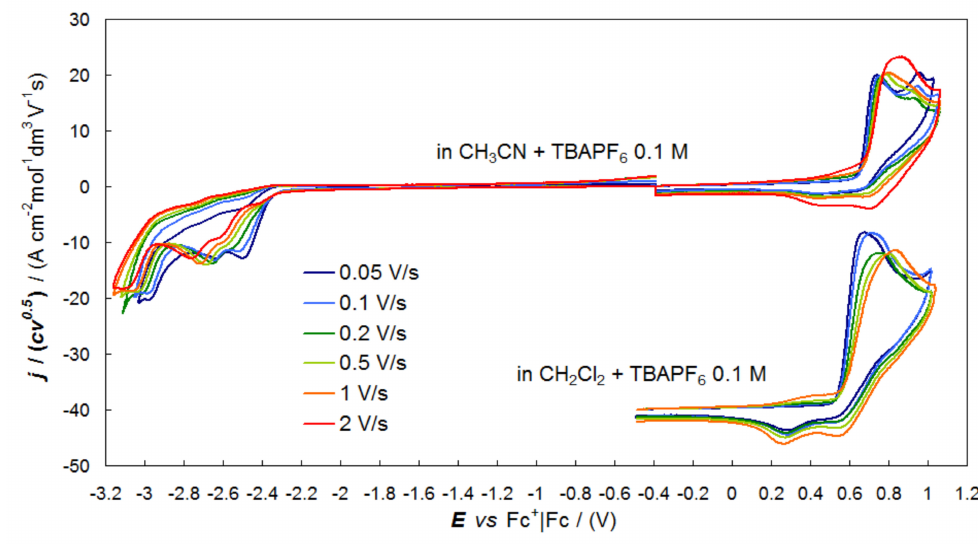
Figure 6. Normalized CV patterns of the Naph 2 T 4 monomer on Glassy Carbon (GC) electrode at scan rates ranging from 0.05–2 V in acetonitrile (CH 3 CN, above) or dichlorometane (CH 2 Cl 2 , below), in both cases with 0.1 M TBAPF 6 as the supporting